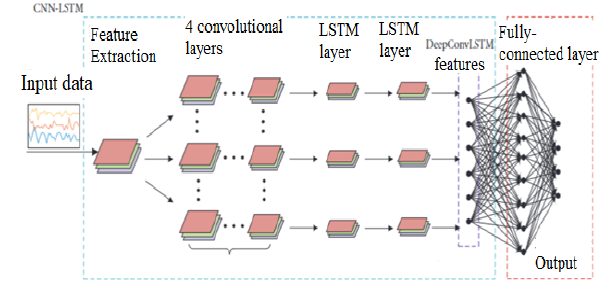
Figure 2 . The structure of the face recognition system